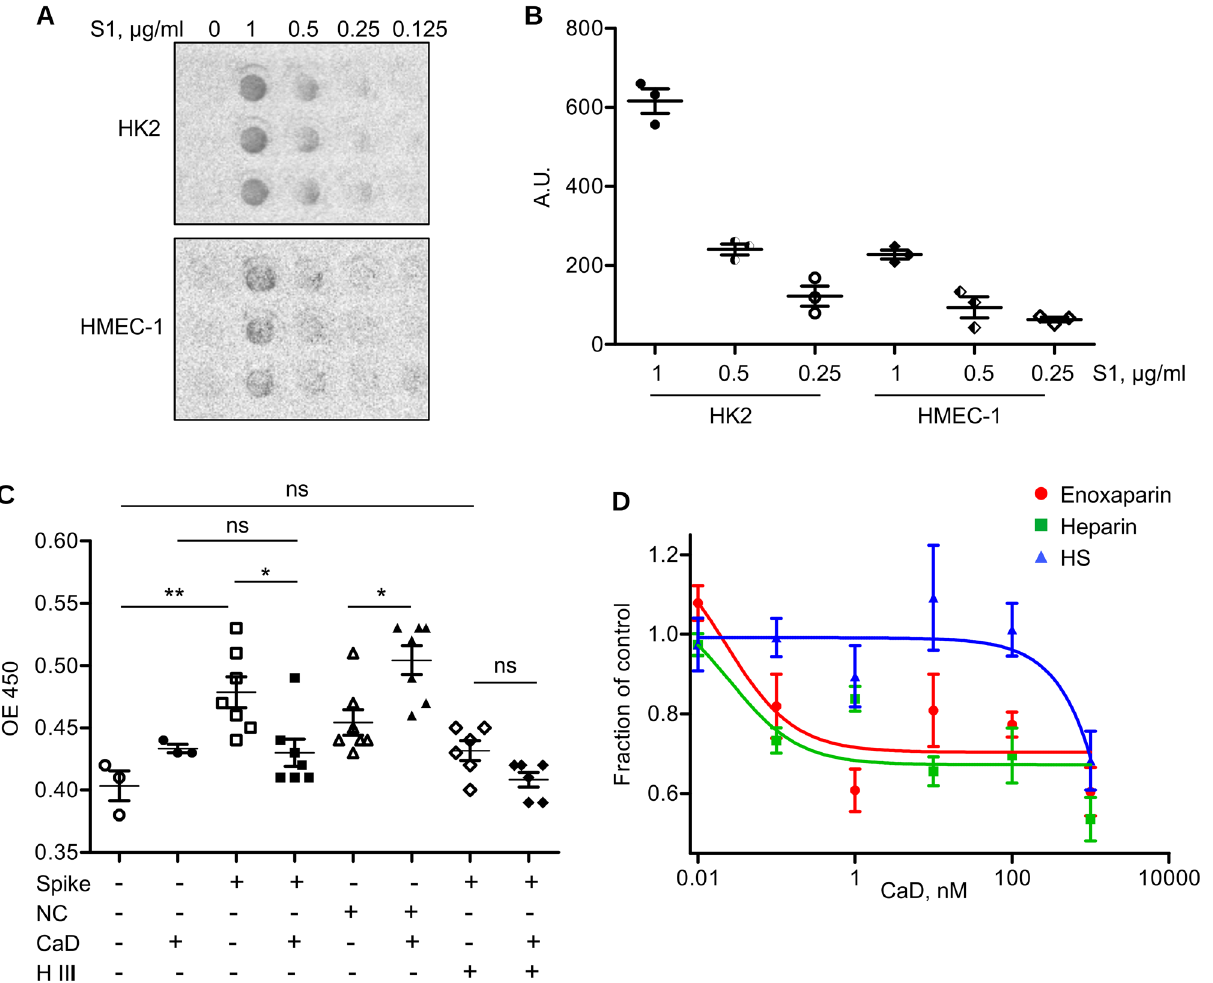
Figure 1. Endothelial and epithelial cells bind recombinant SARS-CoV-2 spike protein. ( A ) Binding of recombinant S1 subunit of SARS-CoV-2 spike protein by HK2 cells and HMEC-1 was assessed by dot blot using anti-spike protein antibody. ( B ) Quantification of the dot blot shown in ( A ). ( C ) Binding of His-tagged recombinant full length SARS-CoV-2 spike protein by HUVECs was assessed by cell-based ELISA using anti- His antibody. CaD (100 µM) was added together with spike protein. SARS-CoV-2 nucleocapsid protein (NC) was used to show the specificity of CaD towards spike protein. Cell were pre-treated with Heparinase III (H III) as indicated to shed HS from the cell surface. ( D ) Inhibition of spike protein binding to heparin, enoxaparin and HS by CaD. Recombinant spike protein was added to the plates coated with heparin, enoxaparin or HS in the presence of CaD. Binding was assessed using anti-His